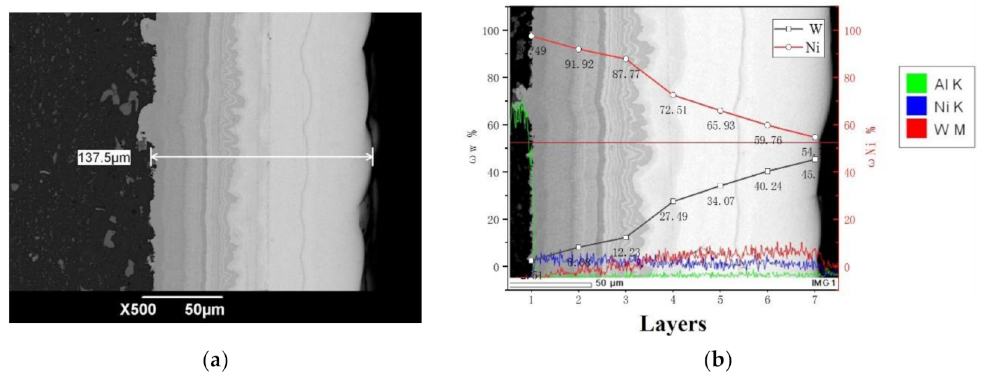
Figure 7. ( a ) The cross-section SEM micrographs; ( b ) The EDS of Ni–W graded